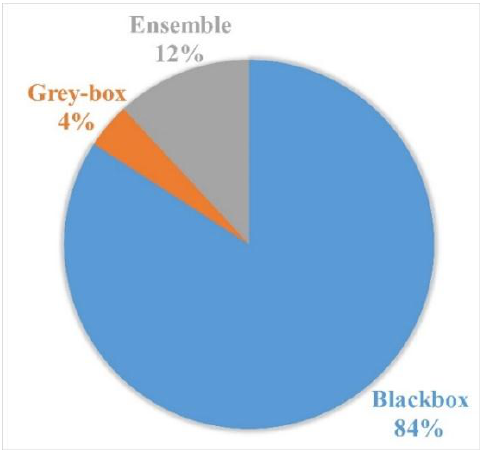
Figure 5. ANN forecasting model types.